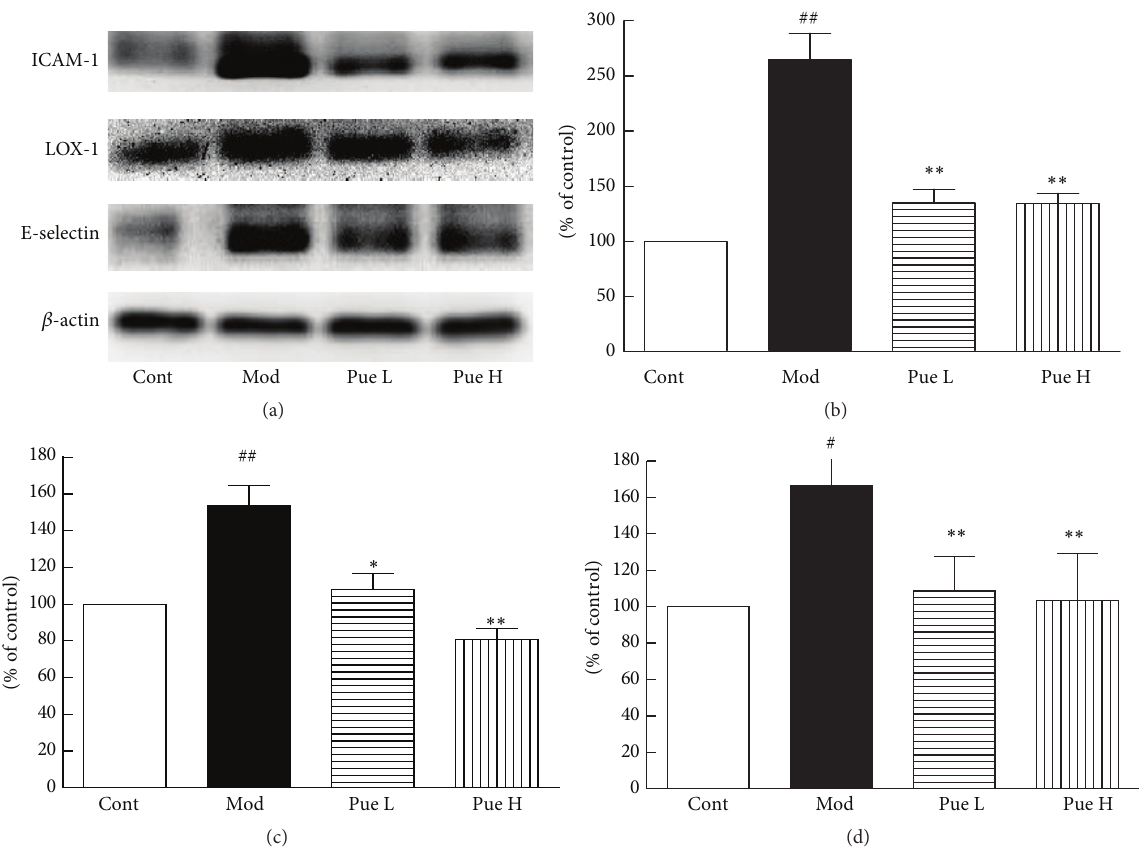
Figure 5: Effect of puerarin on protein expression of ICAM-1, LOX-1, and E-selectin (a) in the aorta of STZ-induced diabetic rats; statistical results for ICAM-1 (b), LOX-1 (c), and E-selectin (d). # 𝑝 < 0.05 and ## 𝑝 < 0.01 versus Cont; ∗ 𝑝 < 0.05 and ∗∗ 𝑝 < 0.01 versus Mod. Cont, control group; Mod, diabetic model group; Pue L, low dosage of puerarin; Pue H, high dosage of